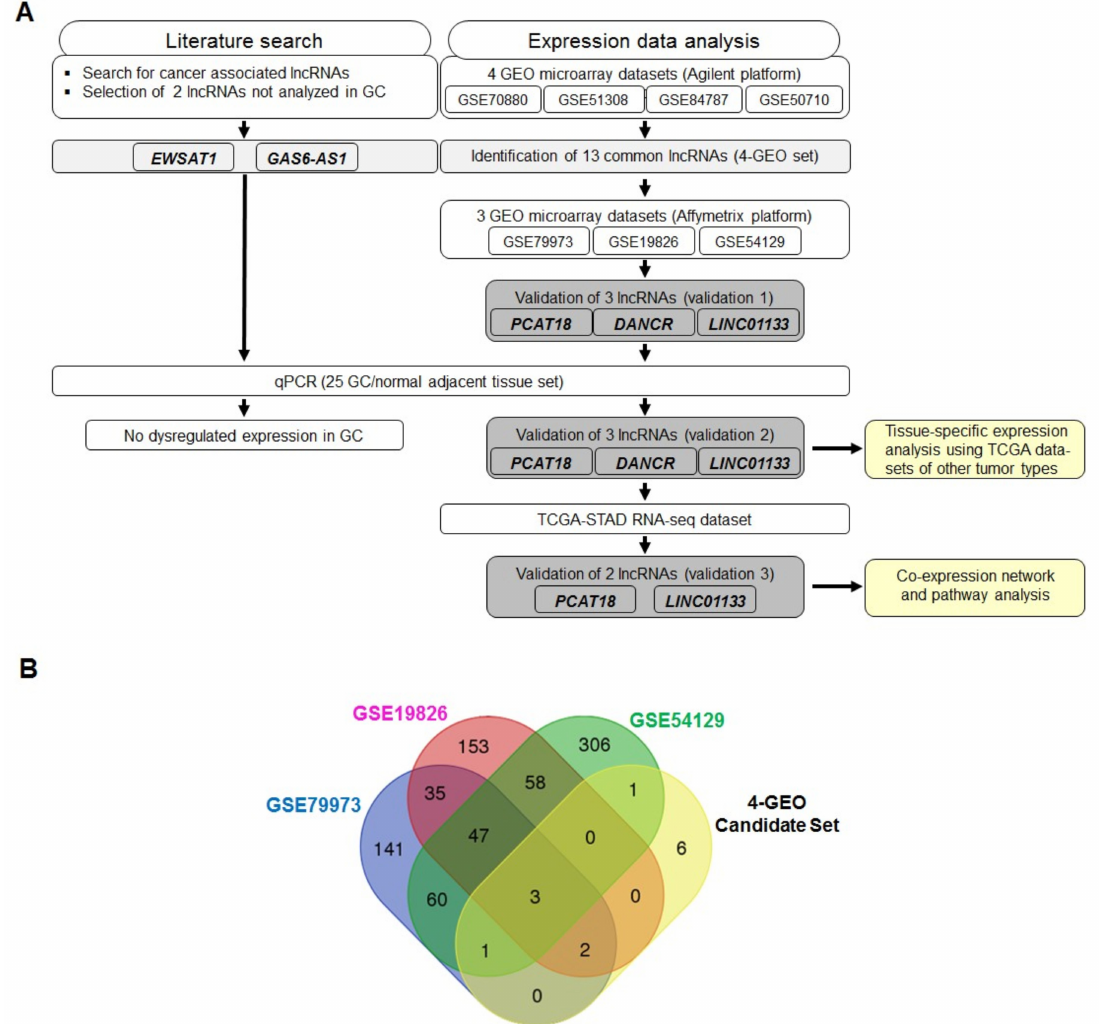
Figure 1. Discovery and selection of long non-coding RNA (lncRNA) candidates. ( A ) Overview of the analysis pipeline; ( B ) Venn diagram showing the number of common and unique lncRNA genes across the GEO datasets. The blue circle represents the lncRNAs found in GSE79973, the pink circle those found in GSE19826, the green circle those found in GSE54129, and the yellow circle the 13 lncRNAs common to the four-GEO set (four Agilent microarray expression datasets of gastric cancer (GC)).